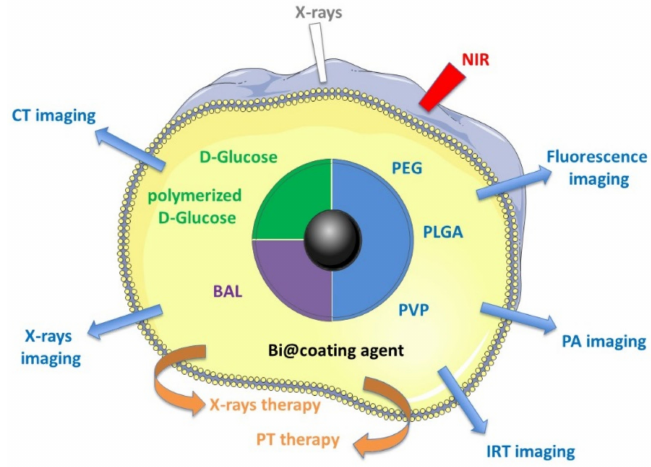
Figure 1. Medical theranostic applications described with different Bi